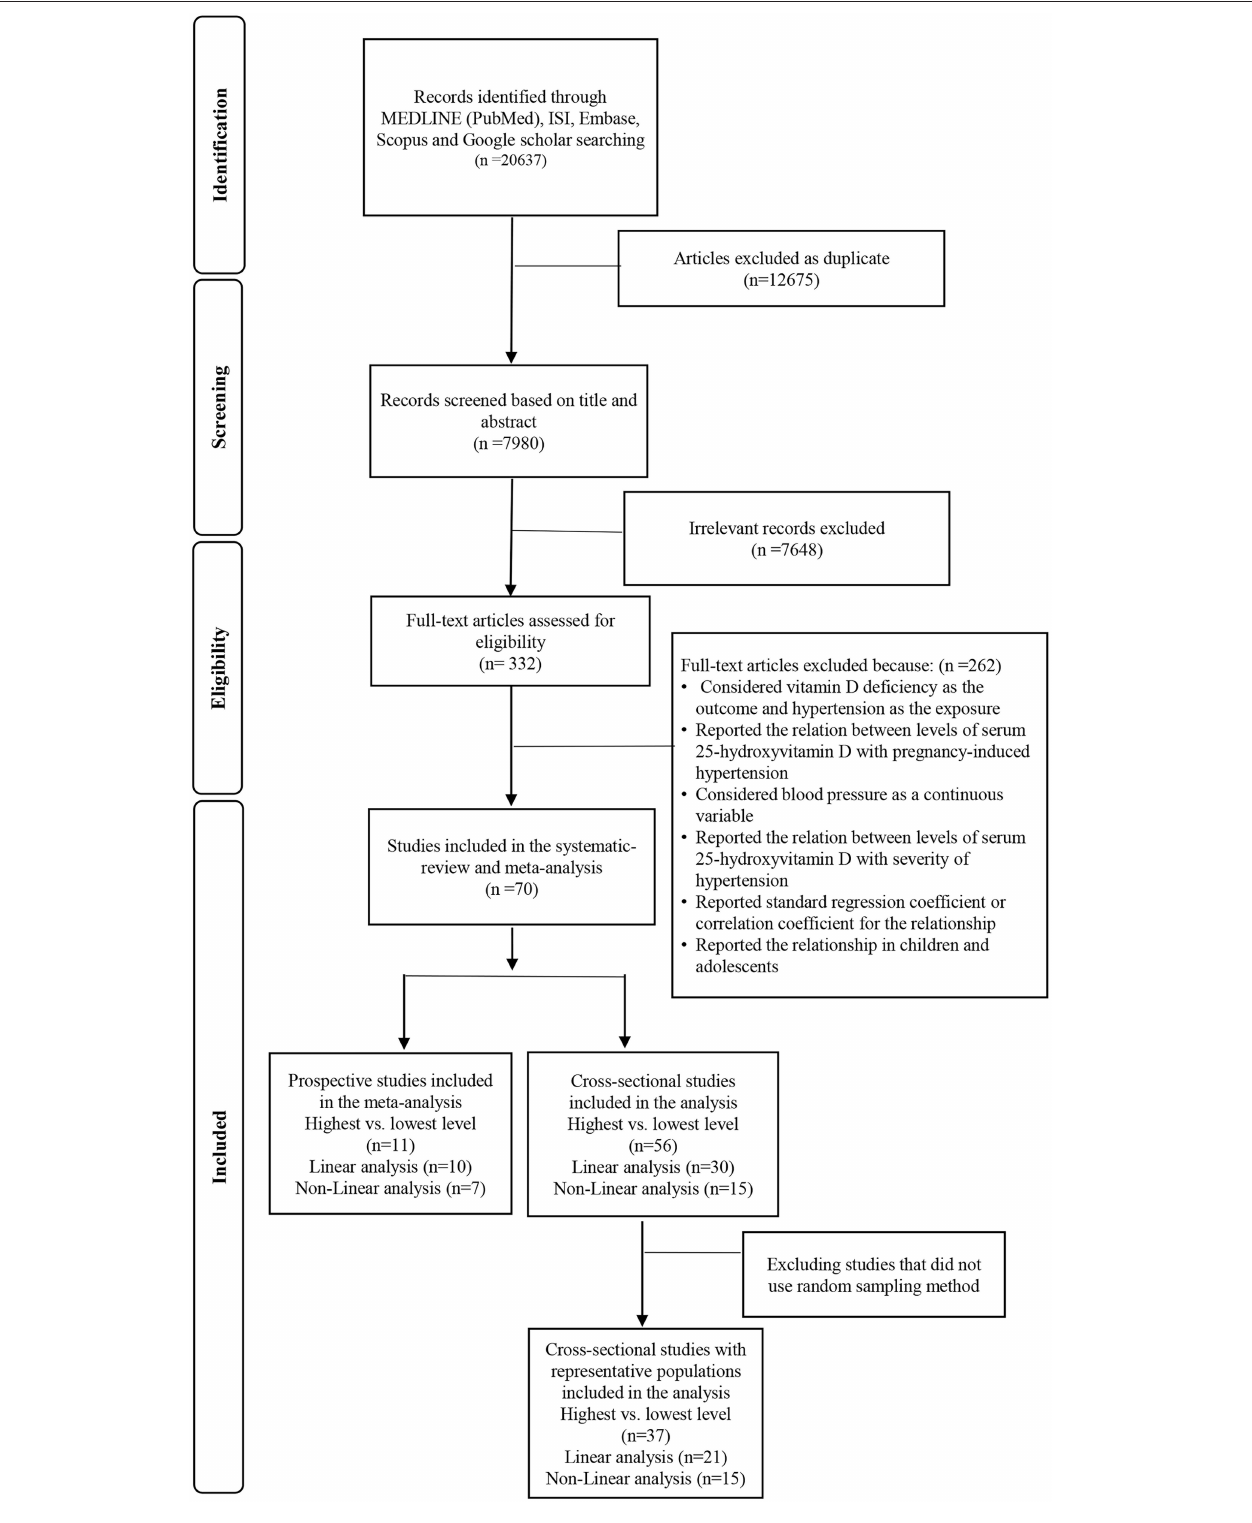
FIGURE 1 | Flowchart of the study selection